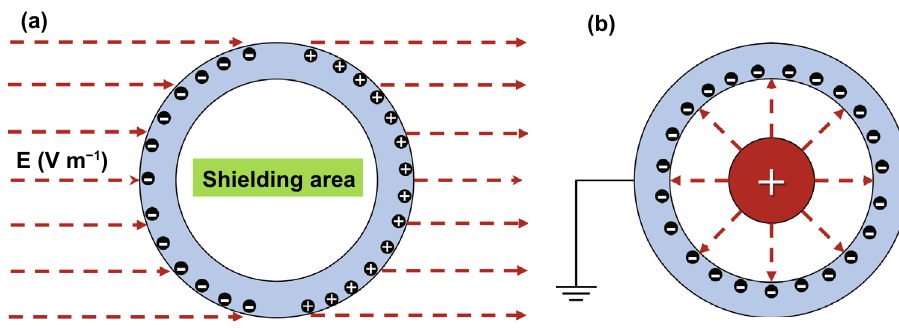
Fig. 1 Schematic diagram of EMI shielding mechanism of a external electric field and b internal electric